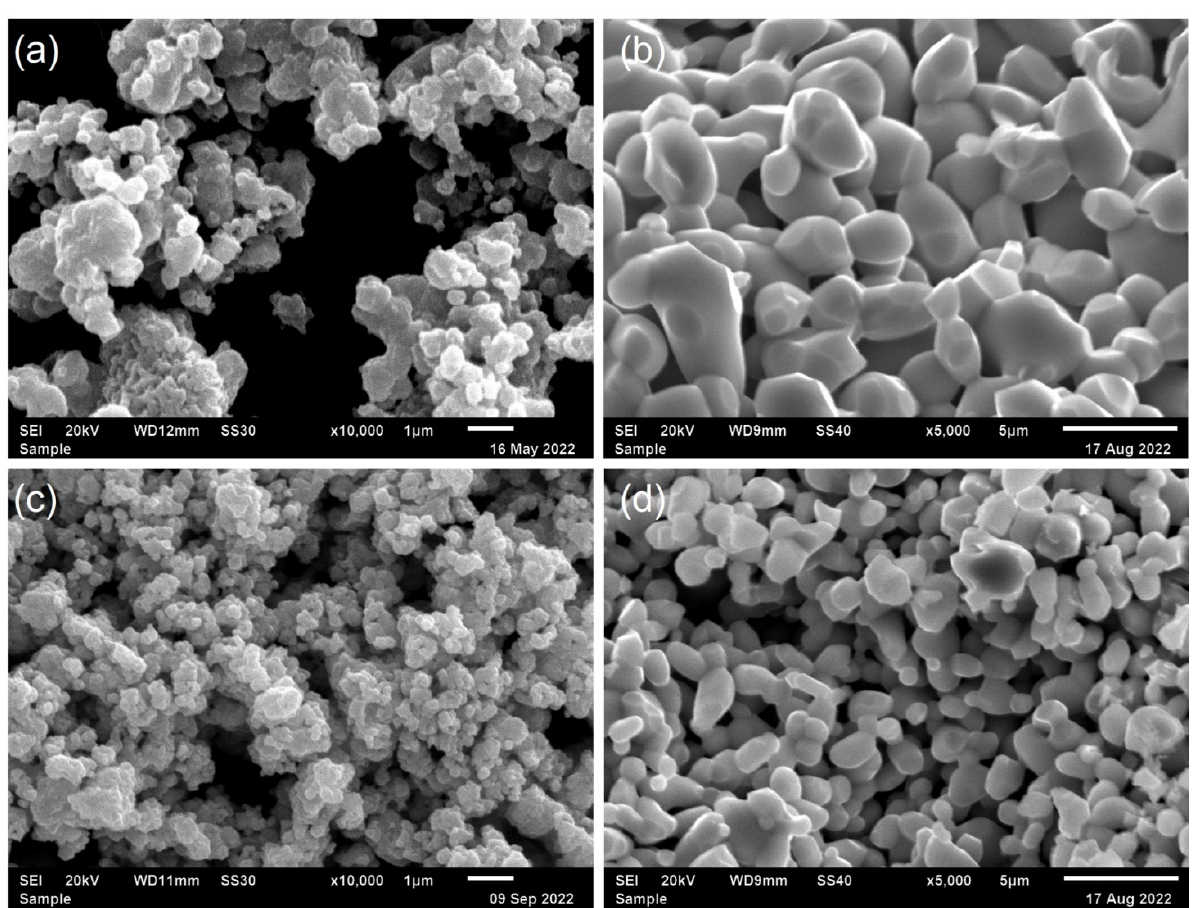
Figure 2. SEM images for FeSbO 4 powder calcined at ( a ) 900 °C and ( c ) 1000 °C for 4 h and fractured cross-sections of FeSbO 4 pellets, ( b ) C-900 and ( d ) C-1000, sintered at 1200 °C for 4 h.